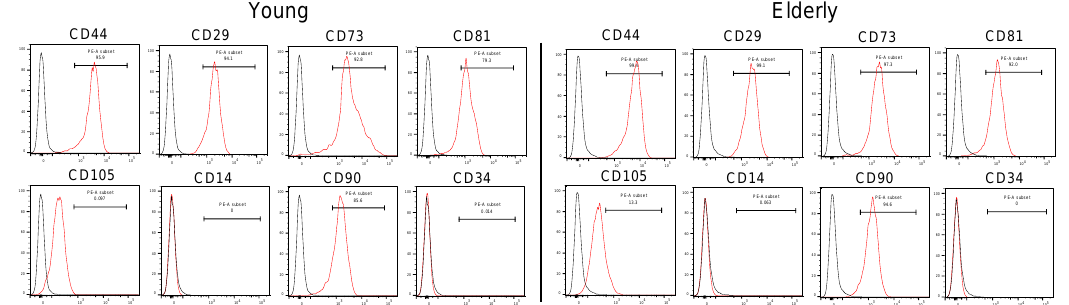
Figure 2. Flow cytometry analysis of dental pulp stem cells (DPSCs) derived from young and elderly patients. DPSCs were cultured at passage 3 (P3) or P4 and surface stained with phycoerythrin-conjugated CD14, CD29, CD34, CD44, CD73 CD81, CD90, and CD105. Fluorescent signals were measured using flow cytometry analysis. Cells that were not treated with fluorescent antibodies were used as controls. Isotype controls are represented by black curves, and labelled cells are represented by red curves. The experiments were repeated three times ( n = 4), and one piece of representative data is presented.